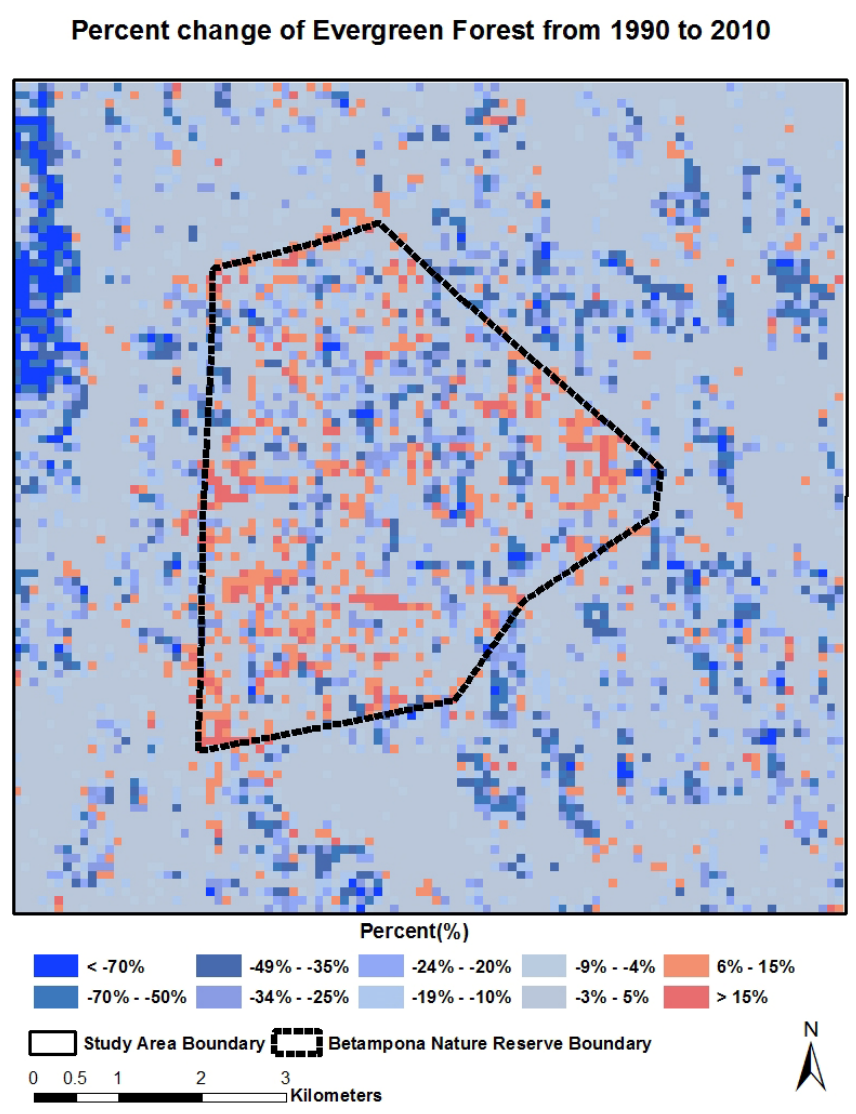
Figure 8. Percentage change of evergreen in each grid cell from 1990 to